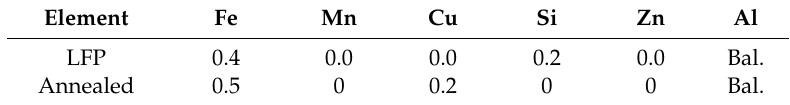
Figure 6. OM images of the etched surface of ( a ) annealed aluminum part; ( b ) LFP-fabricated part in X-Y plane; ( c ) LFP-fabricated part in Y-Z plane. Yellow dashed lines in ( a ) represent the grain boundary; red dashed lines in ( b ) and ( c ) represent the boundry of melt pool; the red arrows in ( b ) and ( c ) represent the grain growth direction; green arrows represent the laser scanning direction in ( b ). Table 2. The chemical compositions (wt. %) of LFP-fabricated and annealed specimens.